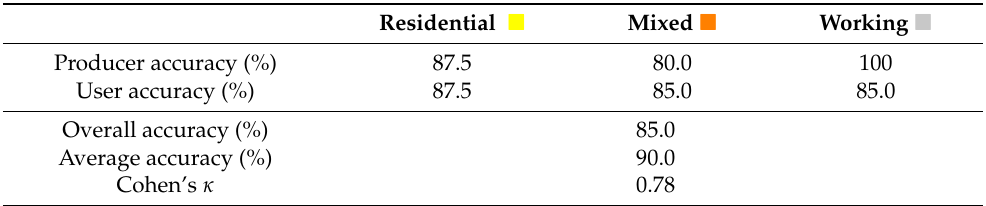
Figure 9. ( a ) Classification result and ( b ) ground truth for the urban land use of the OD zones in Figure 2. Table 1. Producer, user, overall, average accuracies and Cohen’s κ of OD zone classification based on mobility-demand features. Since the number of test zones is 36, the accuracy values are discretised to multiples of 2.5% and only two digits are reported for κ